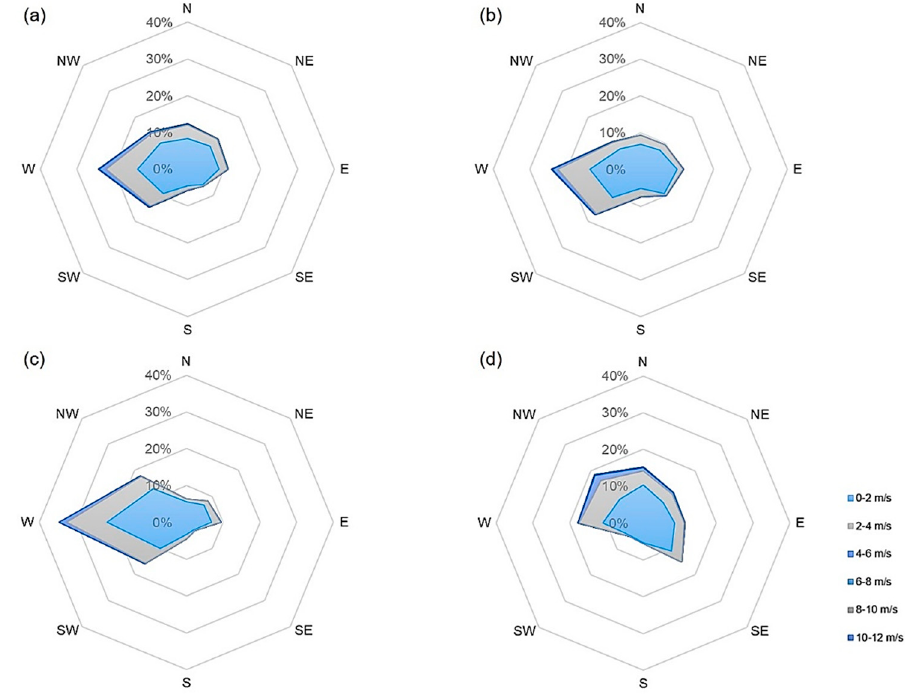
Figure A6. Wind rose from Aero 1 during the measurement campaign in 2019 at the location Emmendingen for the periods ( a ) total: 18.03–14.05, ( b ) pre-flowering: 18.03–09.04, ( c ) main flowering: 09.04–23.04, ( d ) post-flowering: 23.04–14.05.